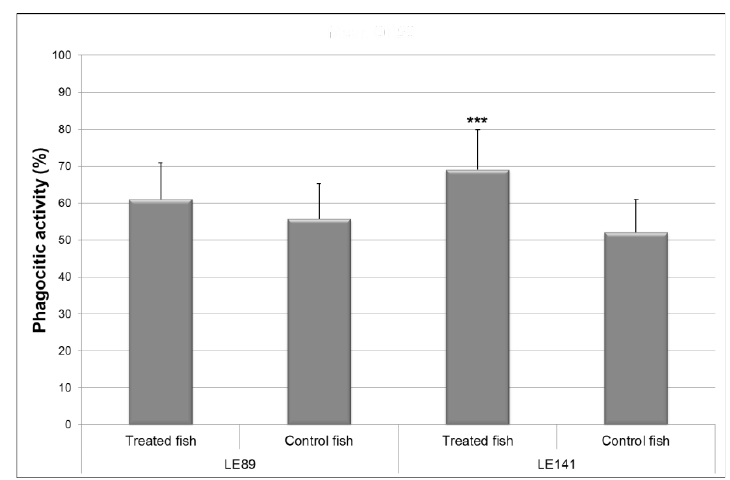
Figure 1. Phagocytic activity of the macrophages of the pronephros in rainbow trout treated with Pseudomonas fluorescens LE89 or LE141 in the tank water. Data are represented as mean ± standard deviation of 12 fish (4 fish from each of the three experimental replicas); *** Statistically significant difference ( p ≤ 0.001) with respect to controls.